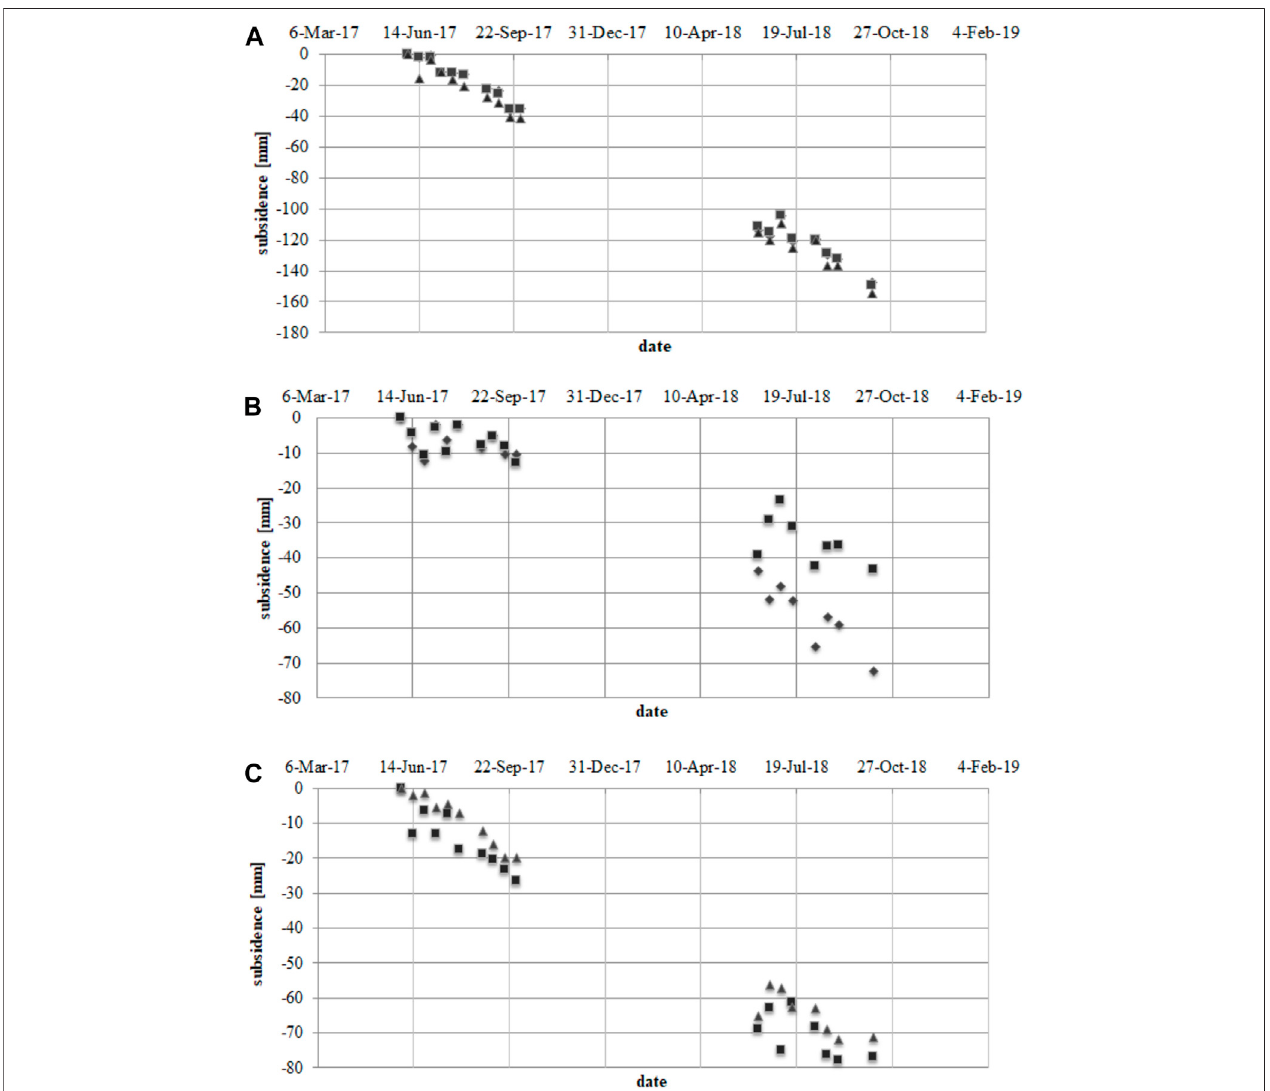
FIGURE6| InSARtime-seriesshowinggradual seasonalsubsidencefor (A,B) and (C) zones (Figures3 , 4 , 6) .Thisanalysisrevealsthatzone (A) issubsidingwith higher rates relative to (B) and (C) zones.